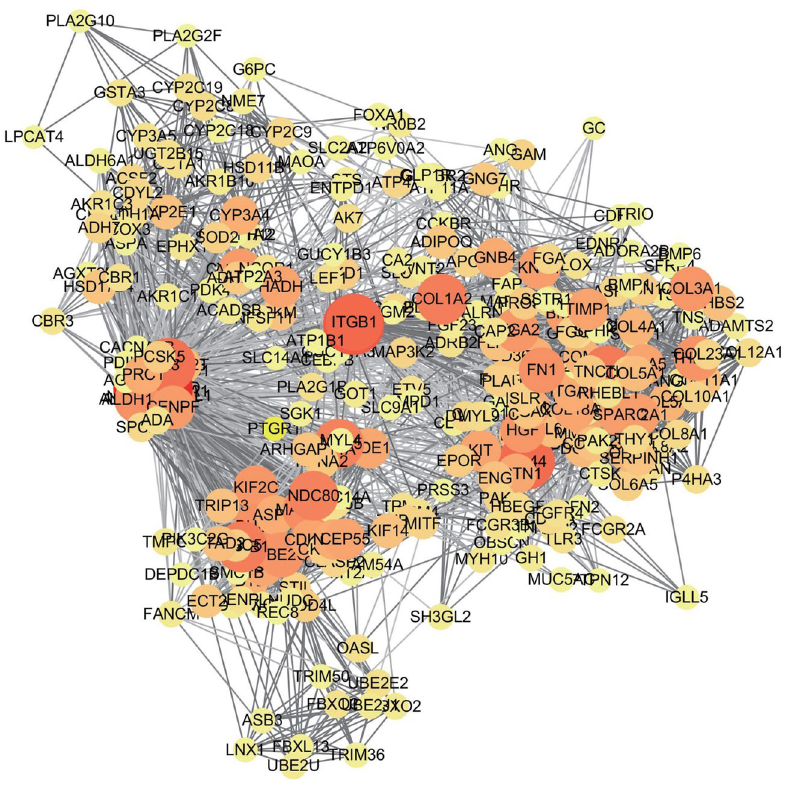
Figure 2. PPI Network plot of differentially expressed genes (drawn by the STRING database 11.0, https:// string- db.